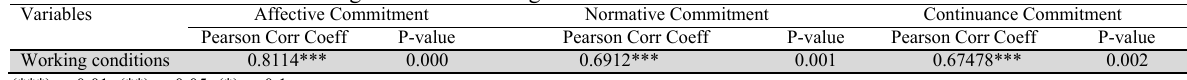
4.2 Global analysis of the relationship between the extrinsic job satisfaction factors and organizational commitment